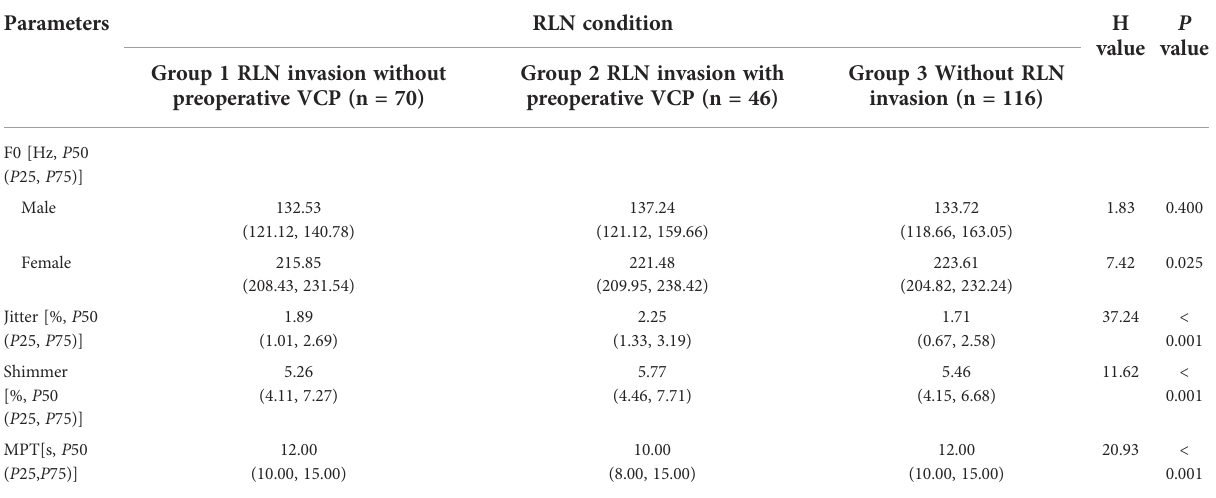
TABLE 1 The acoustic parameters of PTC patients.